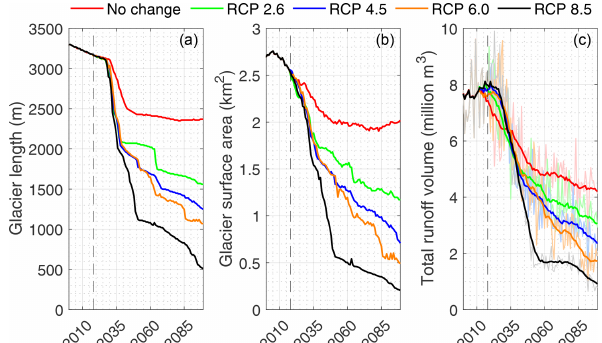
Figure 11. Modelled (a) glacier length, (b) glacier surface area and (c) total annual runoff volume of the Djankuat Glacier for different RCP scenarios until 2100CE. In (c) , the thin lines represent annual values, while the thicker lines represent 15-year moving average. The dashed vertical line denotes the present (i.e. 2017, the most recent year of glaciological